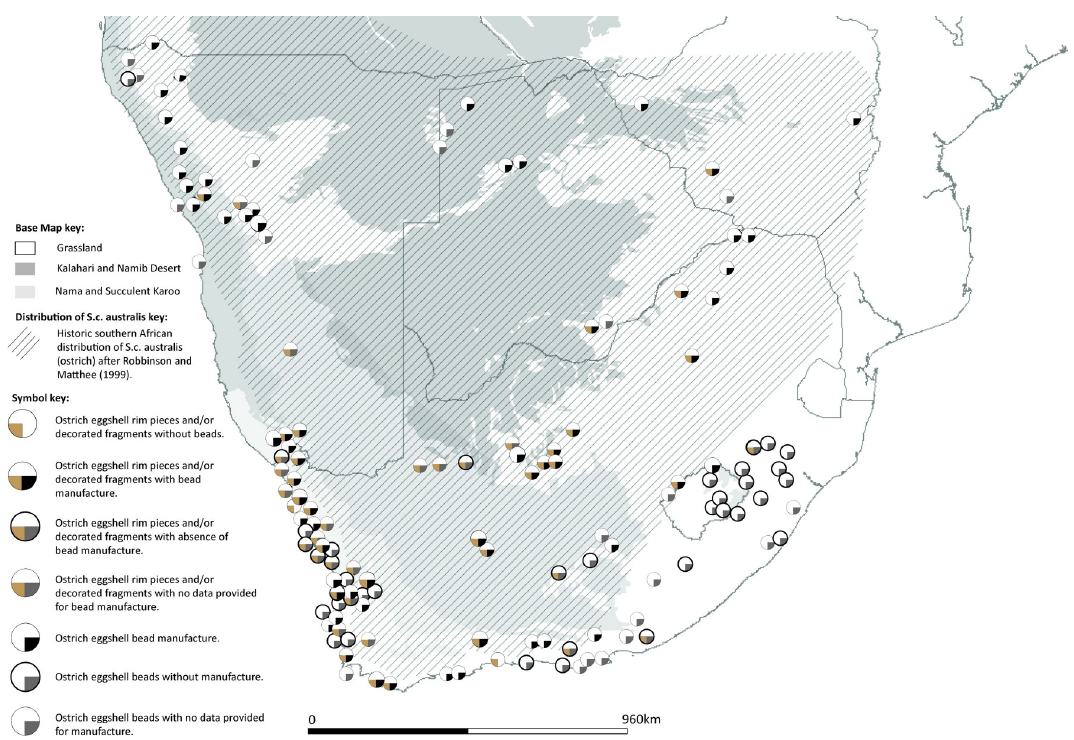
Fig 12. Map showing the distribution of ostrich eggshell finished beads, manufacture sites and containers against the natural habitat of the ostrich.